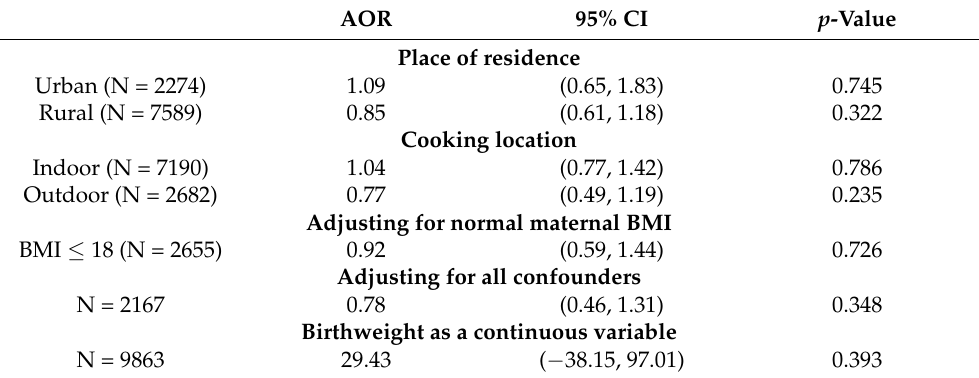
Table 4. Exploratory and sensitivity